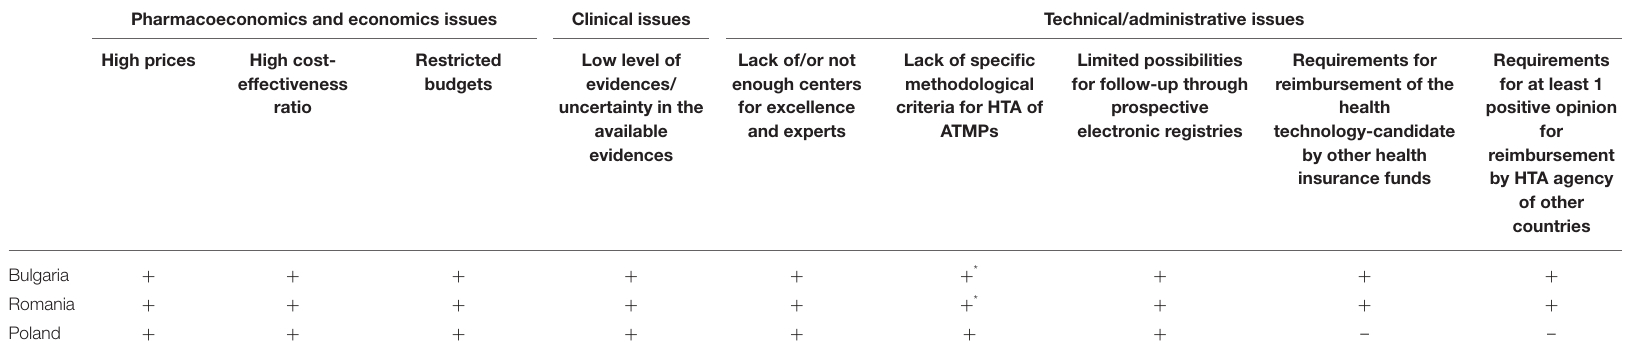
TABLE 3 | Main challenges for reimbursement of ATMPs in Bulgaria, Romania, and Poland.